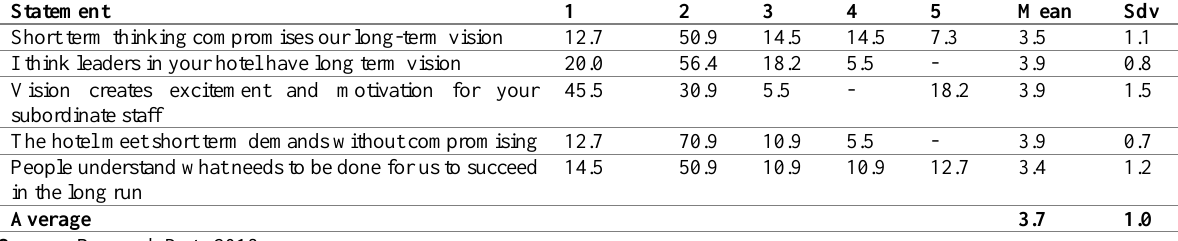
Table 5: Managers’ Perception on Vision of their Respective Hotels